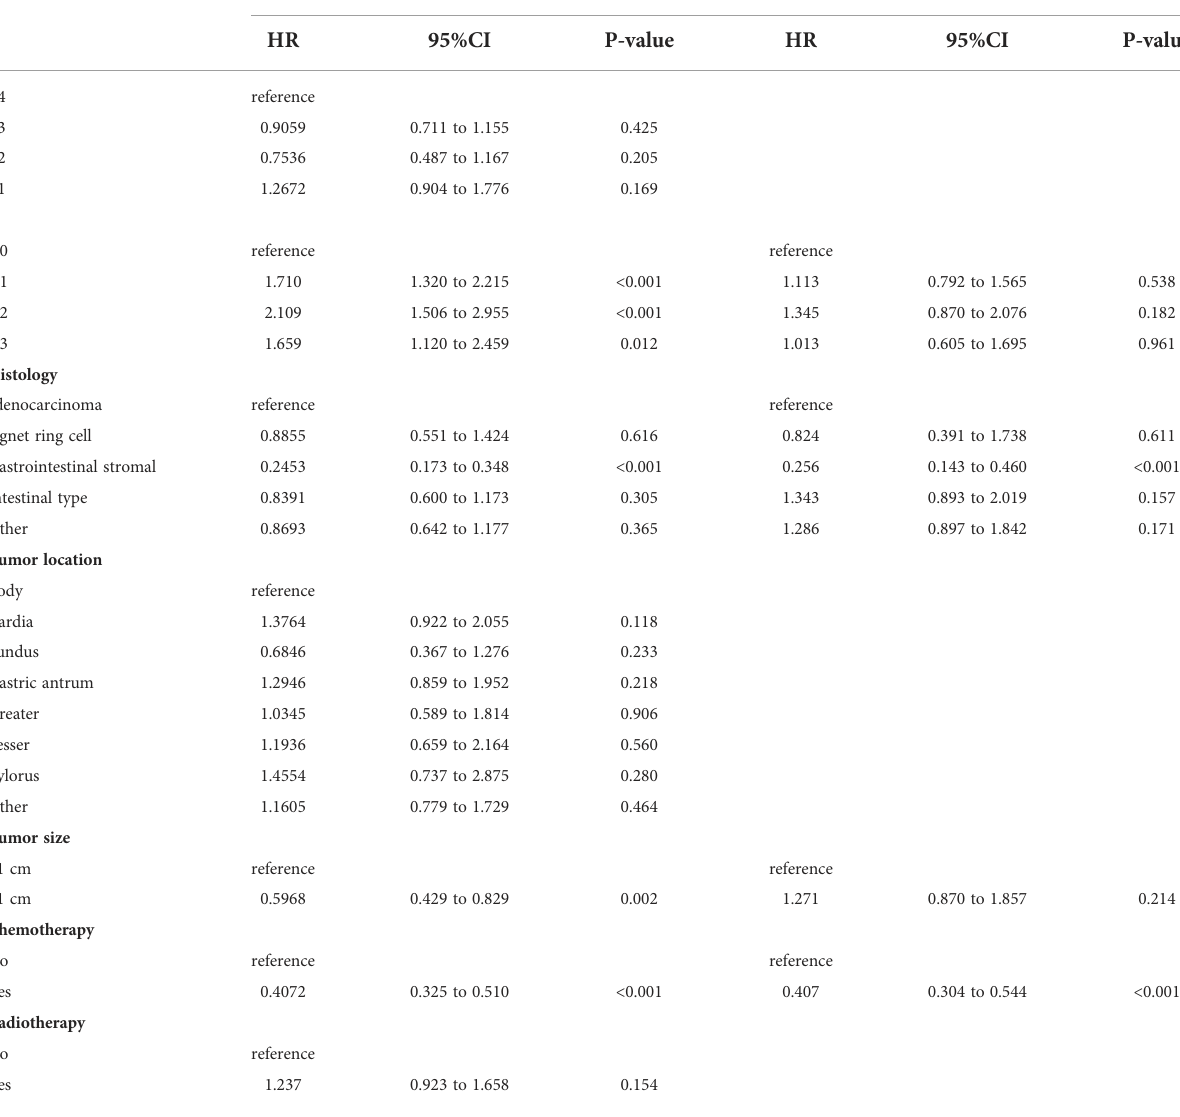
differentiated or undifferentiated tumors (Grades III – IV), the overall survival and cancer-speci fi c survival rates of the PTR group were signi fi cantly higher than those of the no-PTR group (log-rank P <0.001, Figure 4C and log-rank P <0.001, Figure 4D). In the chemotherapy subgroup, the overall survival and cancer-speci fi c survival of the PTR group were longer than the no-PRT group in the patients with chemotherapy (log-rank P <0.001, Figure 5A and log-rank P <0.001, Figure 5B). Likewise, in the subgroup without chemotherapy, the overall survival and cancer-speci fi c survival of the PTR group were also longer than the no-PRT group (log- rank P <0.001, Figure 5C and log-rank P <0.001, Figure